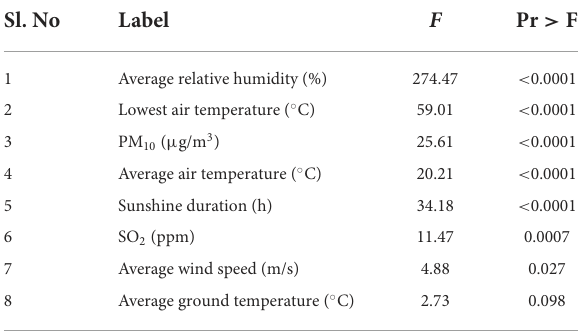
TABLE 1 Stepwise regression model for the environmental risk factors for epistaxis in the study population. Sl.